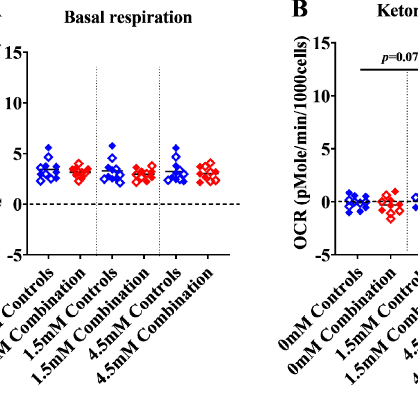
Figure 1. Respiratory capacity increased with increasing concentration of β HOB in both control and combination exposed cardiomyocytes. ( A ) Basal respiration, ( B ) Ketone oxidation, ( C ) Maximal respiration, and ( D ) Spare respiratory capacity in control and combination exposed NRCM. Bars represent mean OCR (n = 10–11 litter per group). Blue color indicates controls and red color indicates combination exposed. Open symbols in the graph indicate males and filled symbols indicate females. Ketone effect is noted with p values, as shown in the figures; there was no group or interaction effect, as determined by two-way ANOVA. mM refers to the progressive concentrations of β HOB supplied.